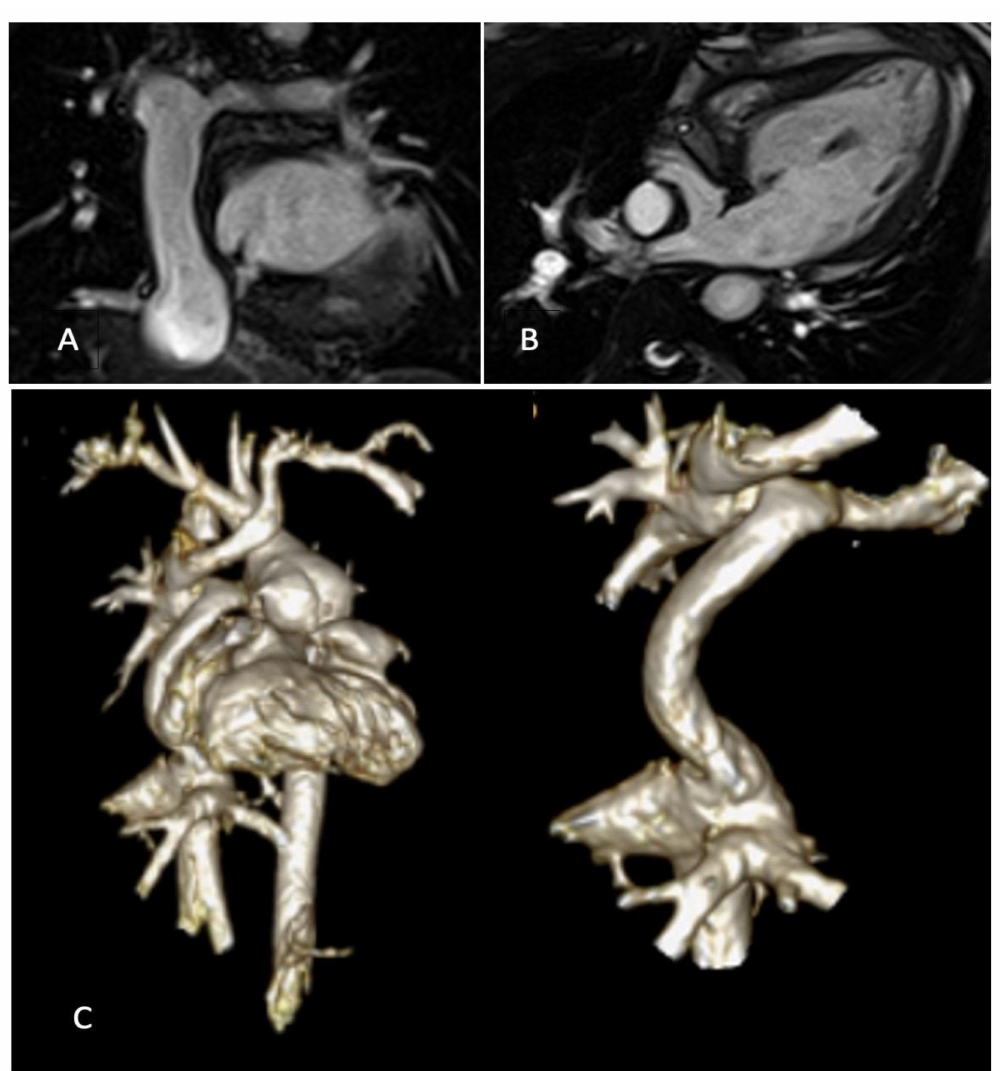
Figure 3. ( A ) bSSFP image of Fontan conduit; ( B ) modified bSSFP four-chamber view with small VSD in the IVS; ( C ) 3D reconstruction of Fontan